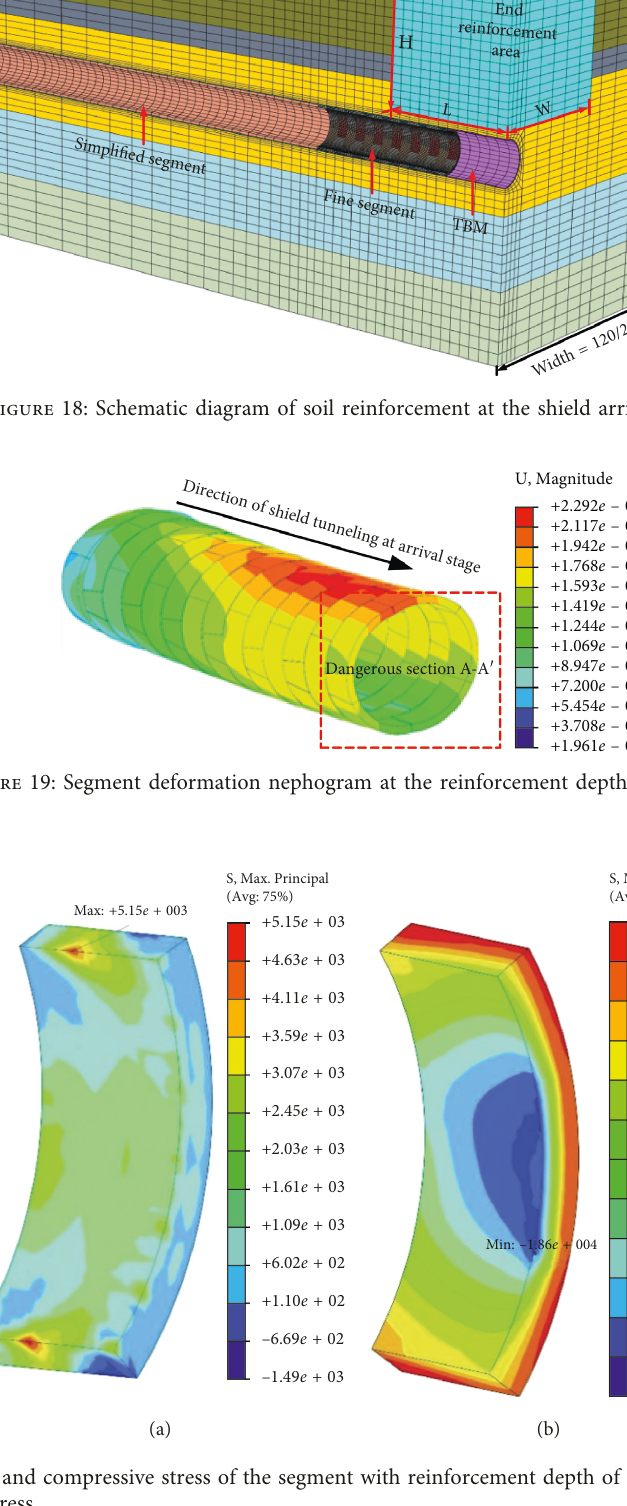
19m. (a) Maximum tensile stress. (cid:31)